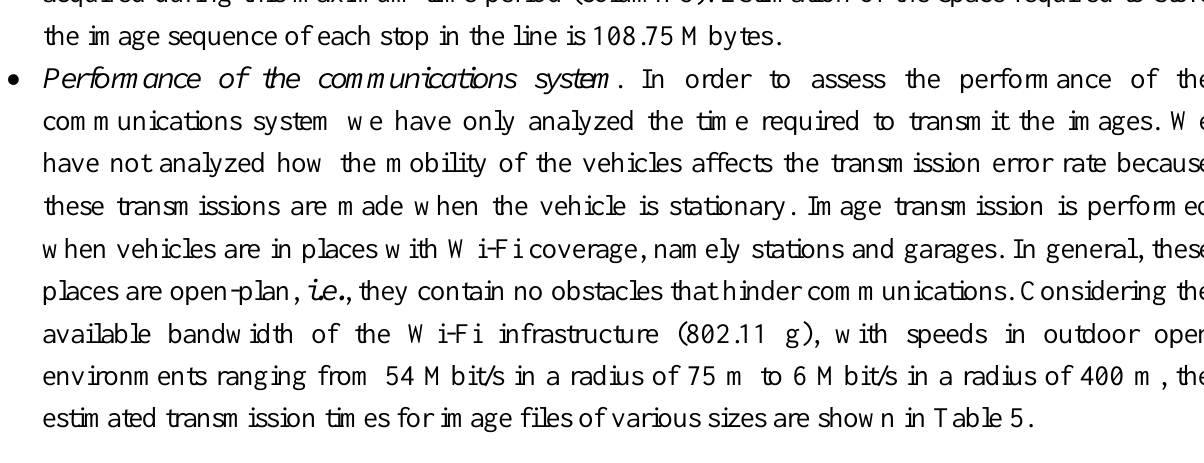
Table 5. Results for the study